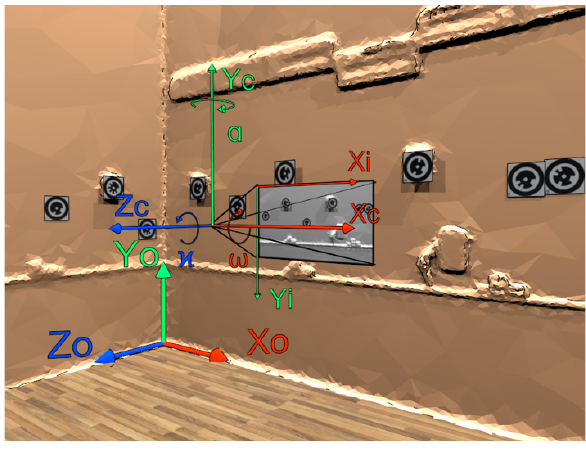
Figure 1. Coordinate